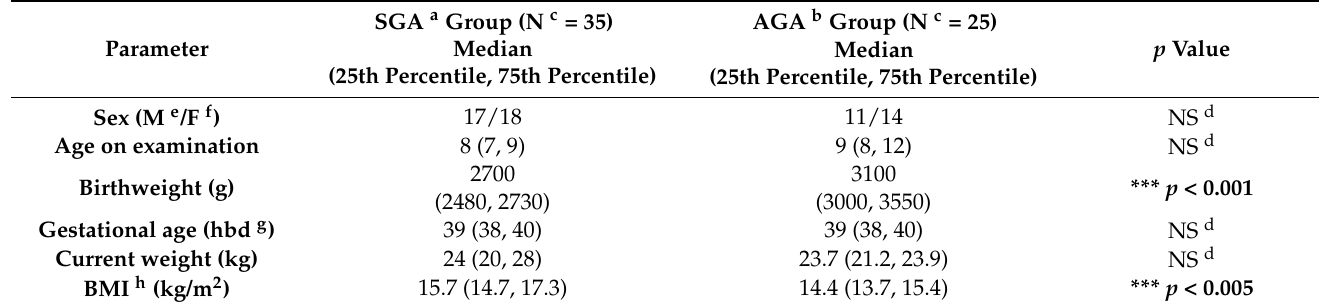
Table 1. Patients’